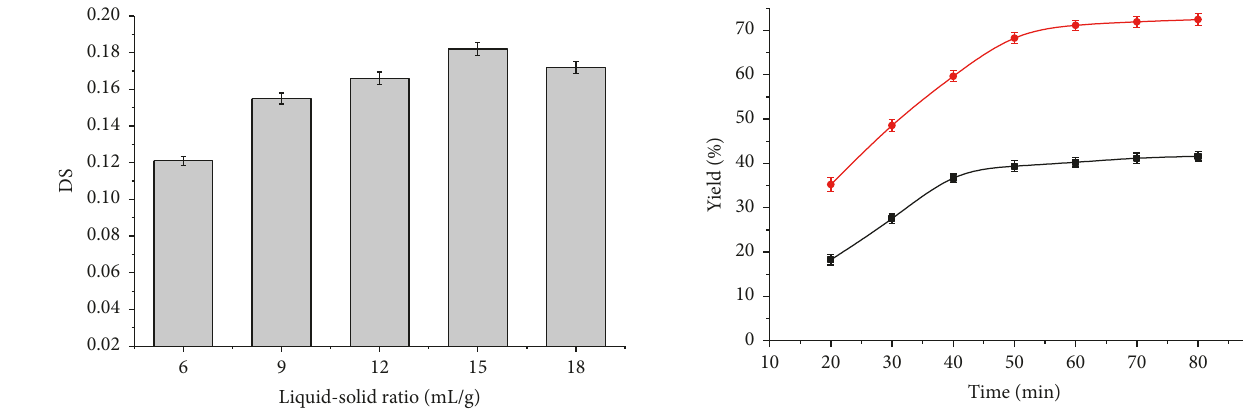
Figure 5: Effect of liquid-solid ratio on DS of cellulose.